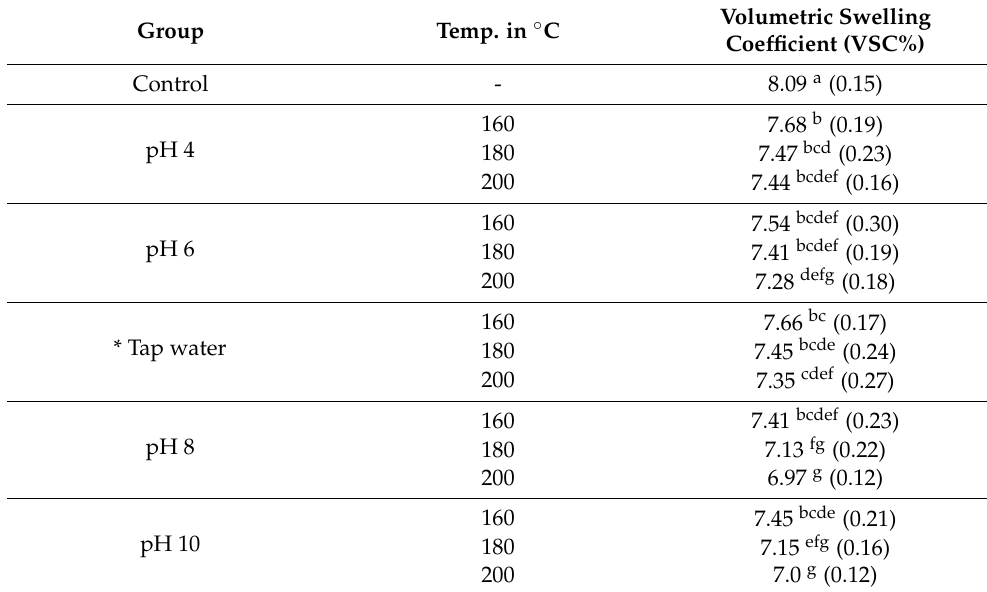
Table 6. Volumetric swelling coefficient of treated and untreated samples of